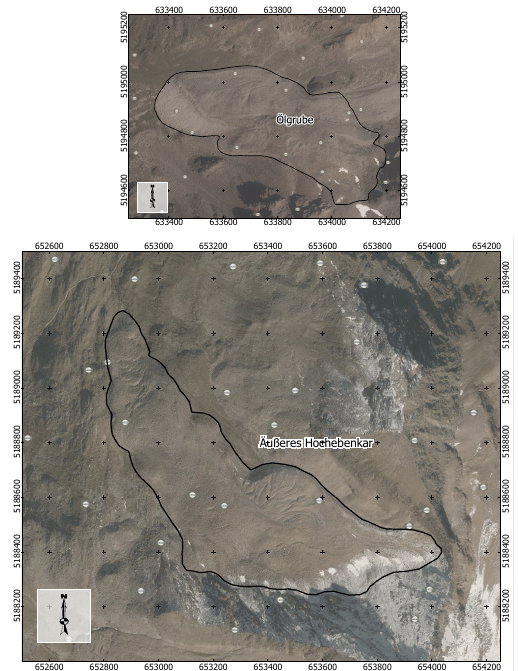
Figure 2: Orthophoto of the areas of interest Ölgrube (top) and Äußeres Hochebenkar (bottom). The outlines of the rock glaciers are denoted by the black lines. Orthophoto: